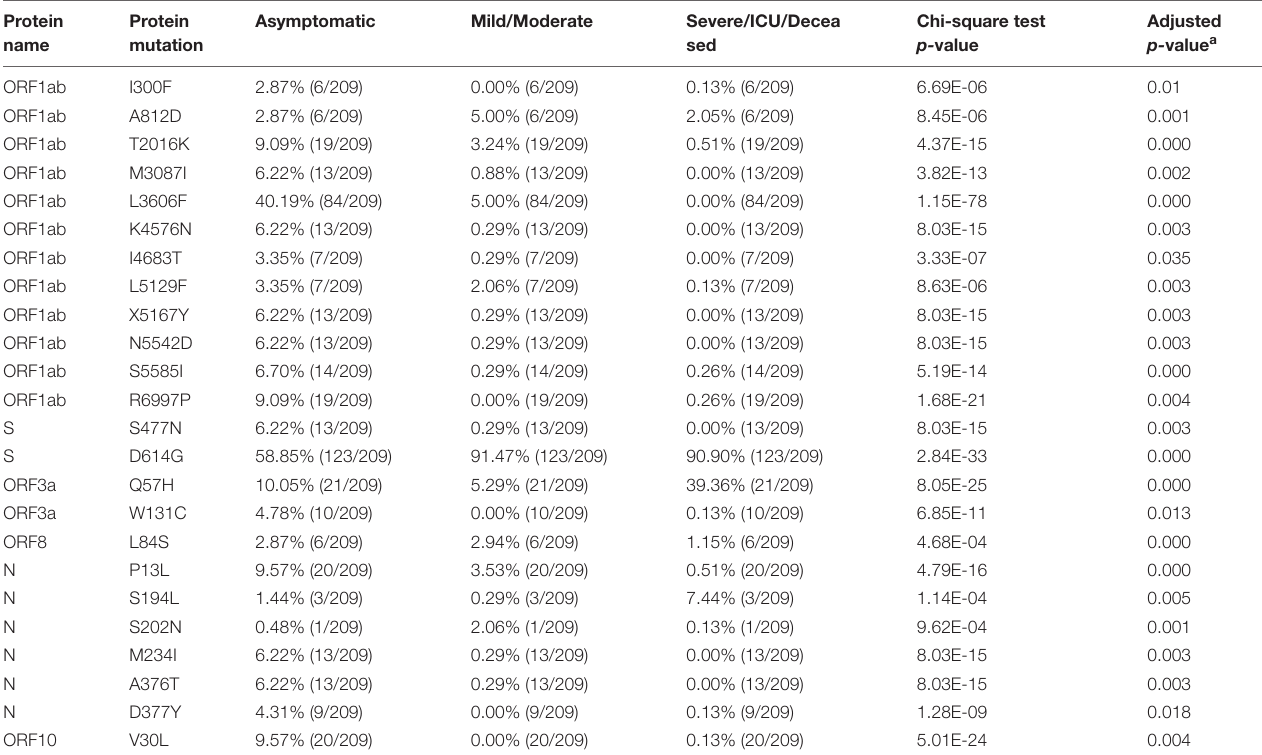
TABLE 1 | SARS-CoV-2 mutations correlated to clinical